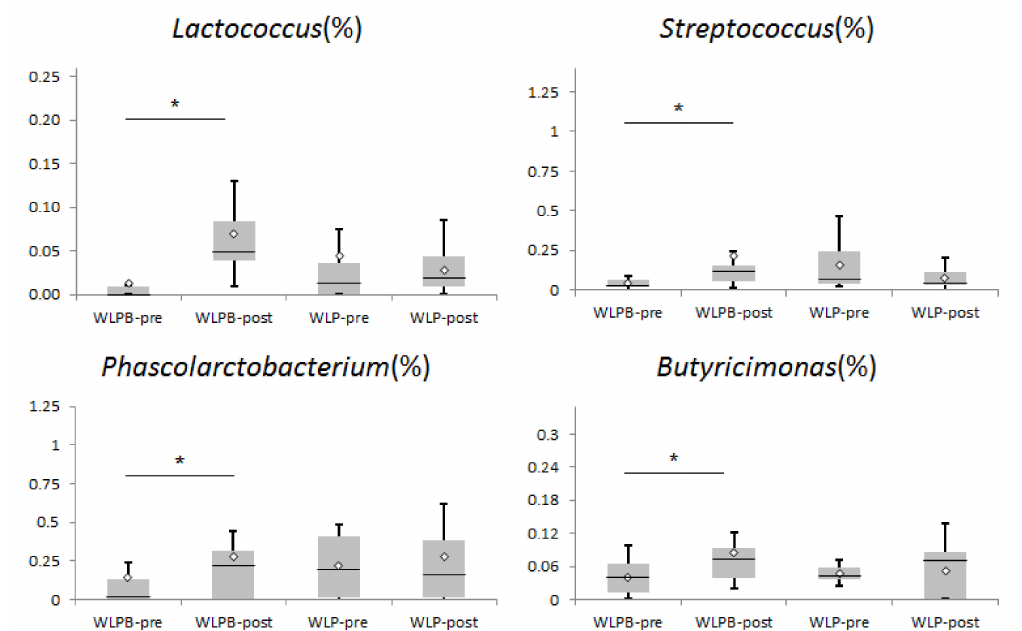
Figure 1. Relative abundance of gut bacteria taxa in the WLP and WLPB groups compared to baseline. WLPB—short-term